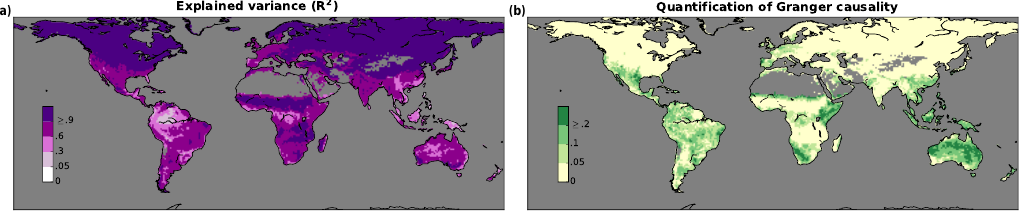
Figure 8. Comparison of model performance with R 2 as the metric with the raw NDVI time series as target variable. (a) Full random forest model. (b) Improvement in terms of R 2 of the full random forest model over the baseline random forest